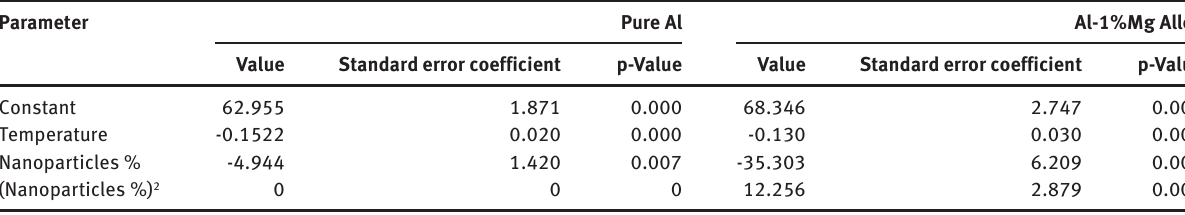
Table 1: ANOVA of the model of the electrical conductivity of the wires. Parameter